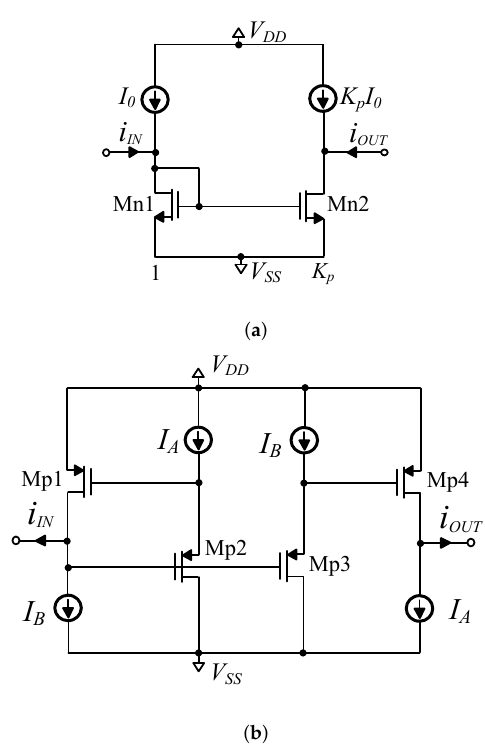
Figure 11. Implementation of the gain stage using a ( a ) current-mirror, and ( b ) a trans-linear